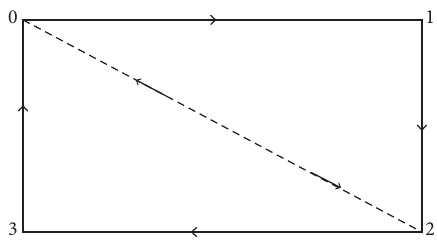
Figure 1: One 2-dimensional surface.